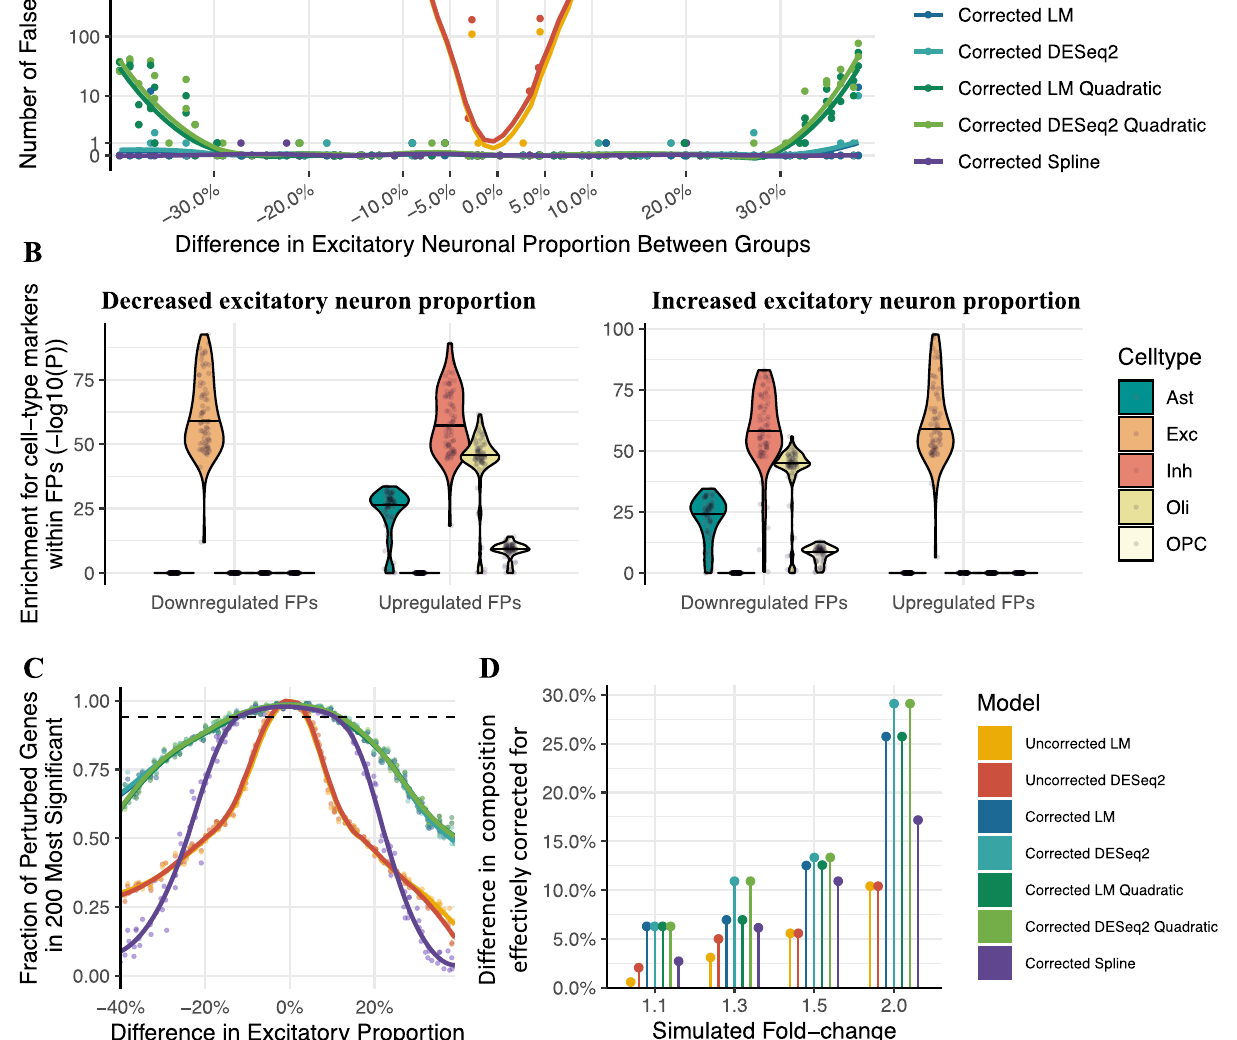
Fig. 4 Effect of brain cell-type composition on Differential expression (DE) analyses. A Scatterplot of the number of false positive genes versus the simulated difference in excitatory neuron proportion between two groups of 50 samples. Each point represents a different simulated dataset. DE was assessed with either a linear model (LM) or DESeq2. Models labelled as “ corrected ” adjusted excitatory neuronal proportion as a covariate. Coloured lines: local regression line. B Cell-type marker enrichment within false positive genes. Each point represents a single simulated dataset. The width of the violin indicates point density, and the horizontal black bar indicates the median. y -axis: enrichment p -value (one-sided Fisher test, no correction for multiple testing); Methods. FPs false positive genes, Ast Astrocytes, Exc excitatory neurons, Inh inhibitory neurons, Oli oligodendrocytes, OPC oligodendrocyte precursor cells. C Scatterplot of the discriminatory power, i.e. fraction of the 200 perturbed genes in the top 200 most signi fi cantly differentially expressed genes ( y -axis) versus simulated difference in excitatory neuron proportion between sample groups ( x -axis) for simulated 1.5-fold expression differences. Coloured lines : local regression line. Dotted line: expected discriminatory power, i.e. 0.95 times the discriminatory power in the absence of cell-type composition differences between groups. D Model robustness to cell-type composition differences across a range of fold-changes, quanti fi ed as the smallest composition change where discriminatory power fell below its expected value. This is de fi ned as 0.95 times the discriminatory power of an uncorrected linear model in a simulation with no composition confound (calculated separately for each simulated gene expression deconvolution on large-scale datasets, focussing the Parikshak et al. dataset included samples from cerebellum on a dataset of control individuals (GTEx 14 , n = 1671 samples; ( n = 84) and cerebral cortex ( n = 167). see the “ Methods ” section), and a dataset of autism spectrum We assessed all combinations of four partial deconvolution disorder (ASD) cases and controls (PsychENCODE; Parikshak methods and nine cell-type signatures, the two enrichment et al. 32 , n = 251 samples; see the “ Methods ” section). The GTEx methods, and coex as a complete deconvolution method data included samples from cerebellum ( n = 309), cerebral cortex (Supplementary Data 3). We also generated an additional ( n = 408), subcortical regions ( n = 863) and spinal cord ( n = 91); signature (MultiBrain) by merging CA, IP, DM, NG, and VL